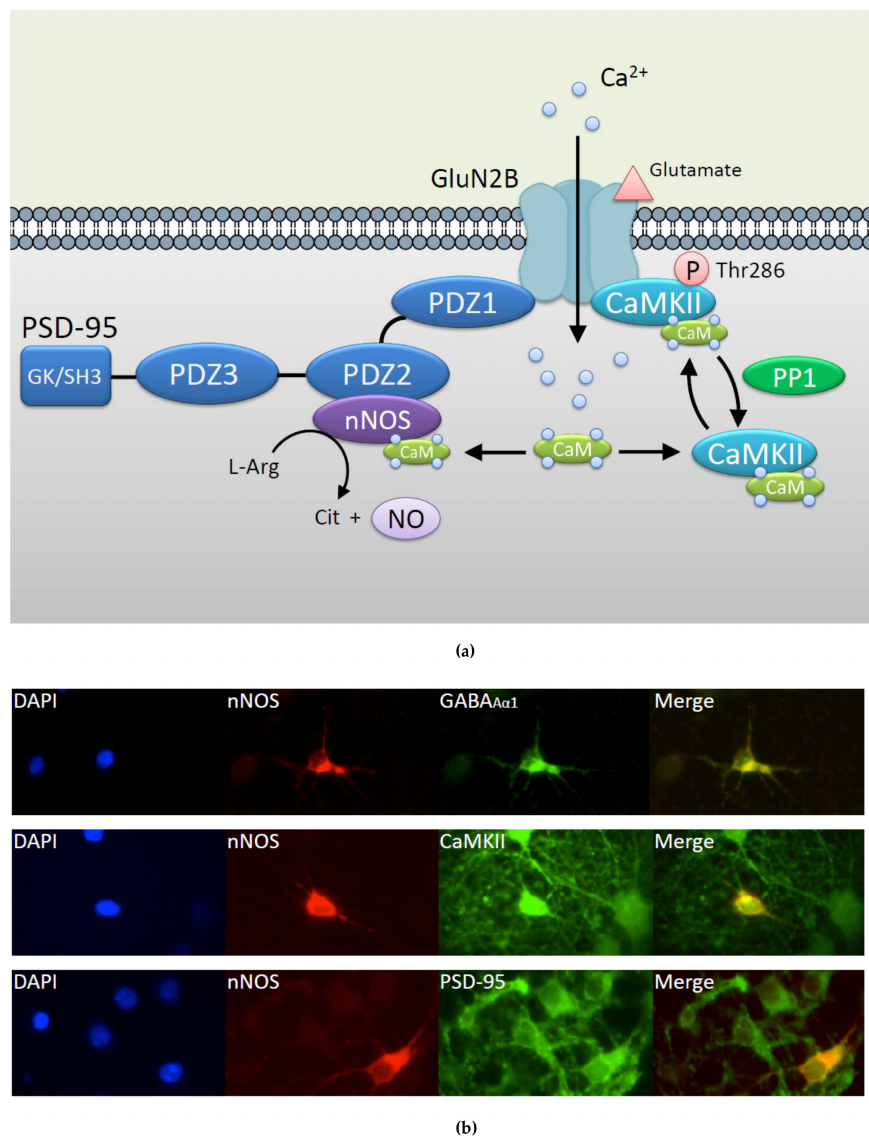
Figure 1. Co-localization of N -methyl-D-Aspartate receptor (NMDAR), post-synaptic density (PSD-95), neuronal NO synthase (nNOS), and Ca 2 + / calmodulin (CaM)-dependent protein kinase II (CaMKII) in neurons. ( a ) CaMKII and nNOS have been linked to NMDAR subunit GluN2B activation. nNOS constitutively binds to PDZ2 domain of PSD-95 associated with GluN2B. Once glutamate activates NMDAR, Ca 2 + influx and intracellular Ca 2 + are increased, which leads to activation of Ca 2 + / CaM binding protein including nNOS and CaMKII. Followed by Ca 2 + / CaM binding, CaMKII is immediately autophosphorylated at Thr286, which promotes interaction between CaMKII and NMDAR. protein phosphatase 1 (PP1), which is found at high levels in the PSD, might primarily be responsible for dephosphorylation of Thr286 and inactivation of PSD-associated CaMKII [22]. Under the Ca 2 + signaling initiated by glutamate, CaMKII and nNOS are co-localized with PSD. This figure is an image of the postsynaptic hippocampal neuron where the mutual regulation of nNOS and CaMKII mainly exists. ( b ) Immunostaining micrograph images of representative rat hippocampal neurons. Panels show 4 (cid:48) ,6-diamidino-2-phenylindole (DAPI) (blue: nuclear stain), nNOS (red), γ -aminobutyric acid (GABA) A α 1 (green, upper), CaMKII (green, middle), PSD-95 (green, lower). The panel in the most-right column (labelled “Merge”, shown by the yellow fluorescence) shows the overlaid image of nNOS and either GABA A α 1 (upper panel), CaMKII (middle panel), or PSD-95 (lower panel). Note that nNOS co-localizes with GABA A α 1 -, CaMKII-, and PSD-95-positive